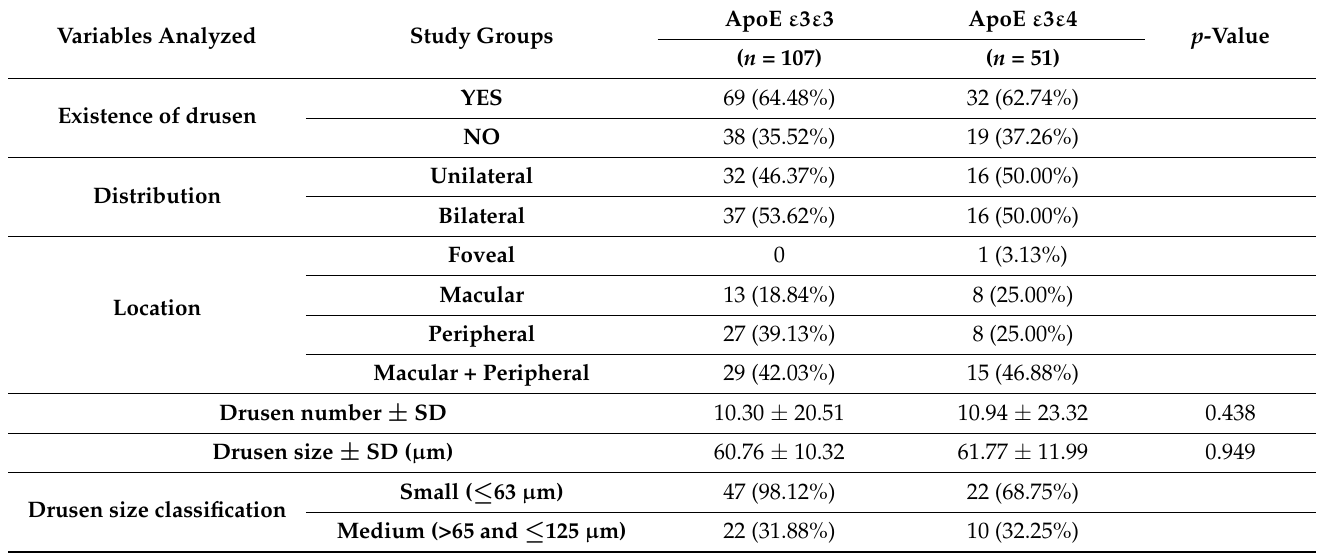
Table 3. Characterization of drusen in subjects according to ApoE genotype.